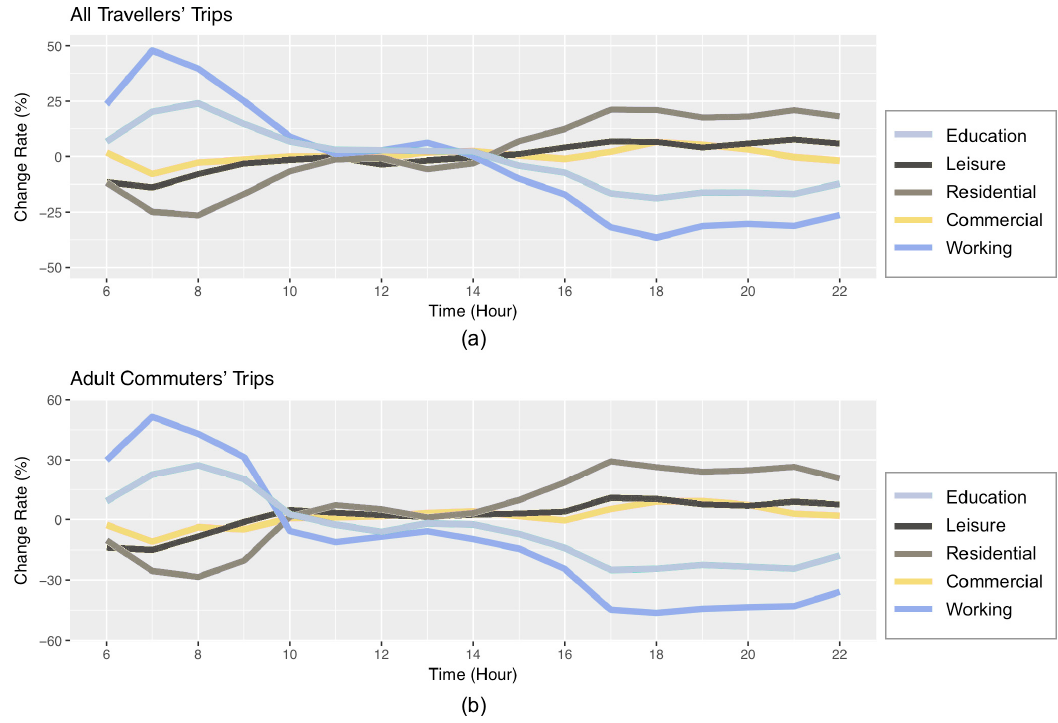
Figure 8. Change rate for different categories of land use for ( a ) all travellers and ( b ) commuters.